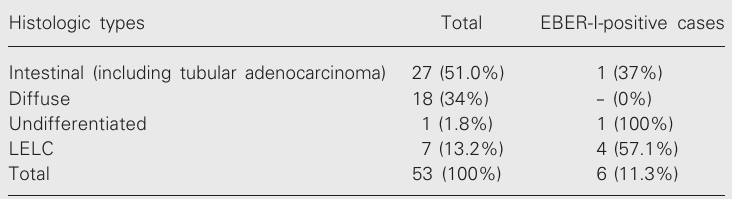
Table 1. Distribution of gastric carcinomas in Brazilian patients by histologic type.